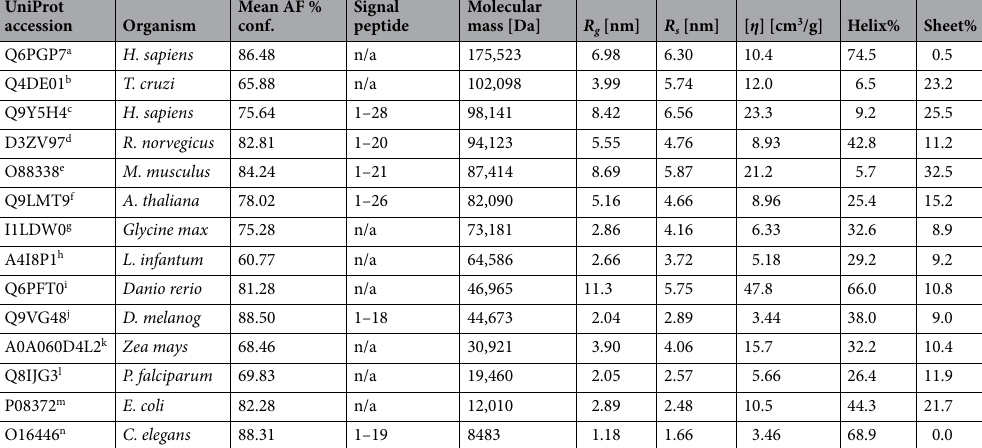
Table 2. Some calculated parameters for a selection of AF-v1 predicted structures with no RCSB PDB counterparts, ordered by decreasing molecular mass. The corresponding structures and calculated p ( r ) vs. r distributions and CD spectra can be seen in Fig. 3. a Tetratricopeptide repeat protein 37. b Trans-sialidase, putative. c Protocadherin gamma-a1. d Vomeronasal 2 receptor, 50. e Cadherin-16. f Putative wall-associated receptor kinase-like 13. g Aminotran_5 domain-containing protein. h Adenosine deaminase-like protein. i Flotillin. j Lipase. k BHLH transcription factor. l RNA-binding protein, putative. m Prepilin peptidase-dependent protein C. n Uncharacterized